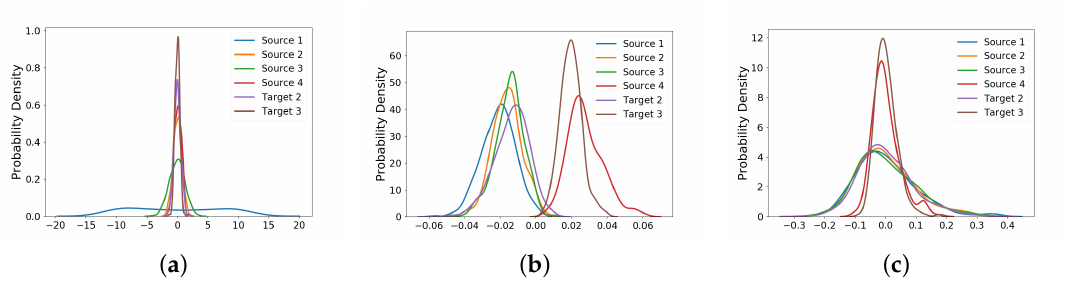
Figure 16. Probability density distribution of six training bearings with ( a ) raw time signal, ( b ) HHT marginal spectrum feature, and ( c ) deep feature extracted by domain adaptation DAE.